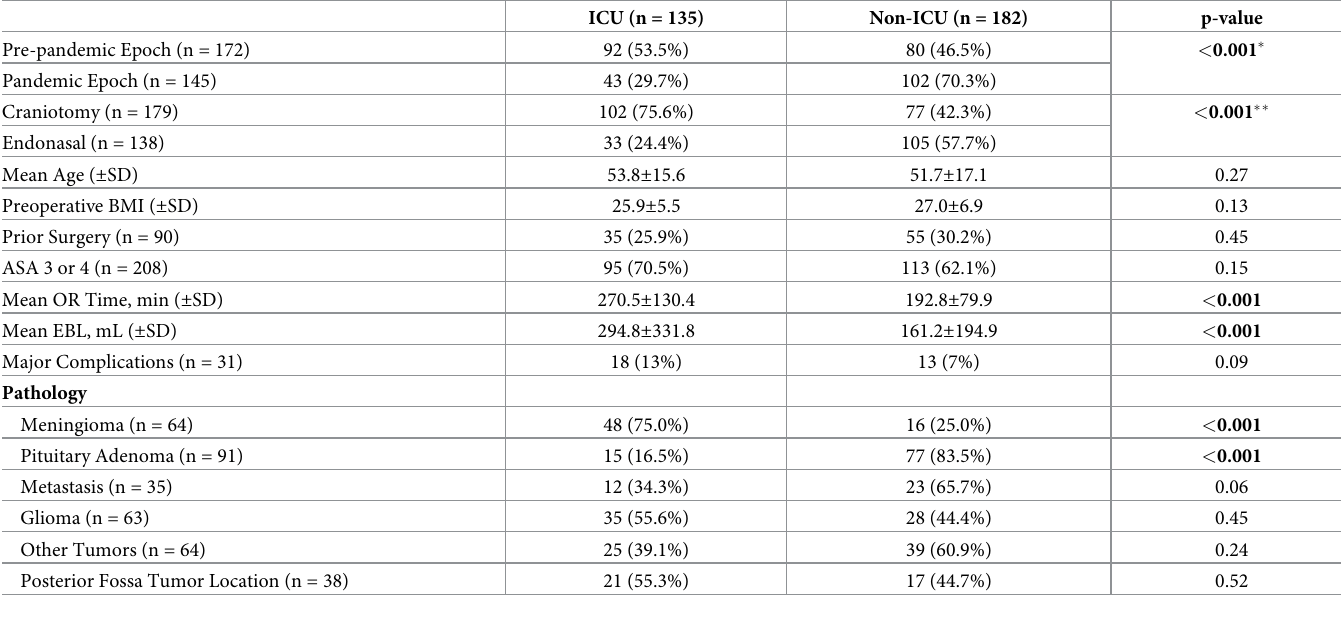
Table 4. Factors associated with ICU versus non-ICU